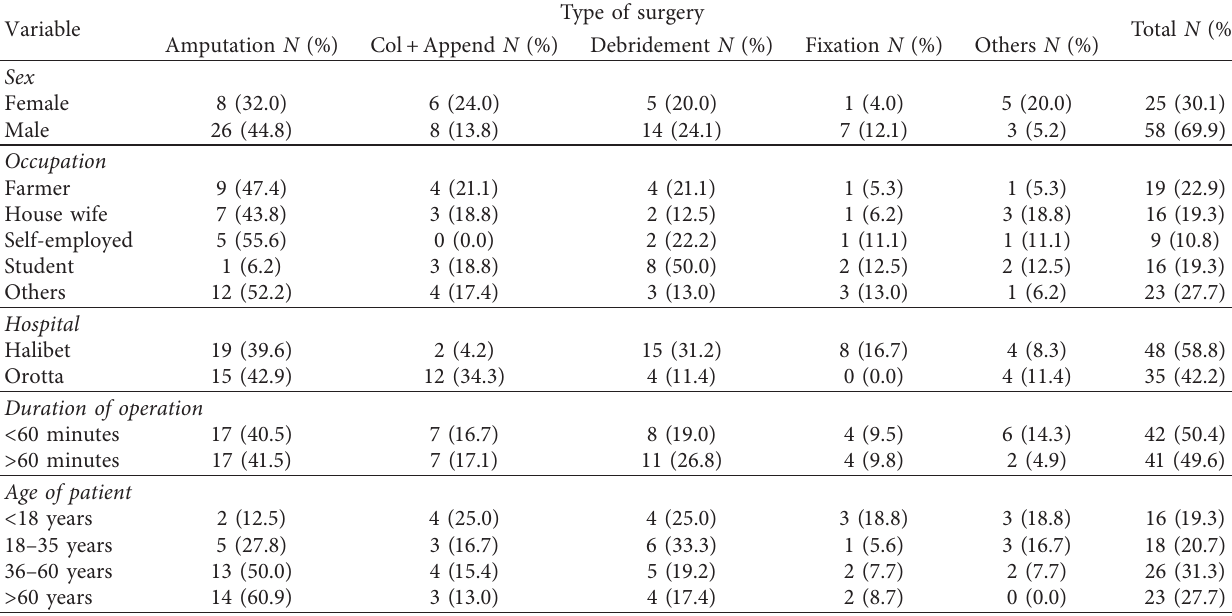
Table 1: Characteristics of patients with positive culture from surgical wards in the Halibet and the Orotta National Referral Hospital in Asmara, Eritrea, 2017.